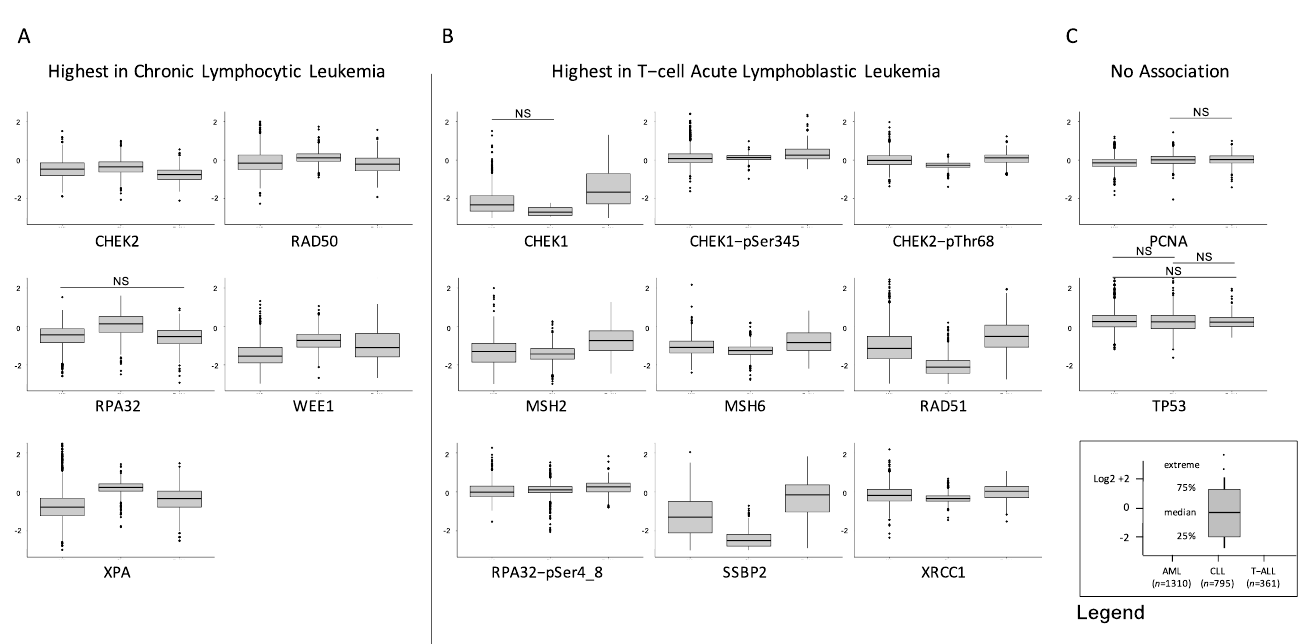
Figure 3. Differential expression of DDR proteins by disease. Individual box plots comparing the expression of AML (left, n = 1310), CLL (center, n = 795) and T-ALL (right, n = 361) are shown for the 16 DDR proteins. Most proteins fell into one of three patterns: ( A ) Highest expression in CLL, with expression in T-ALL either above or equal to that of AML ( n = 5 proteins), ( B ) Highest expression in T-ALL, followed by lower expression in AML, and then by expression in CLL that was either lower or equal ( n = 9 proteins), ( C ) No association with disease ( n = 2), NS = not significant.